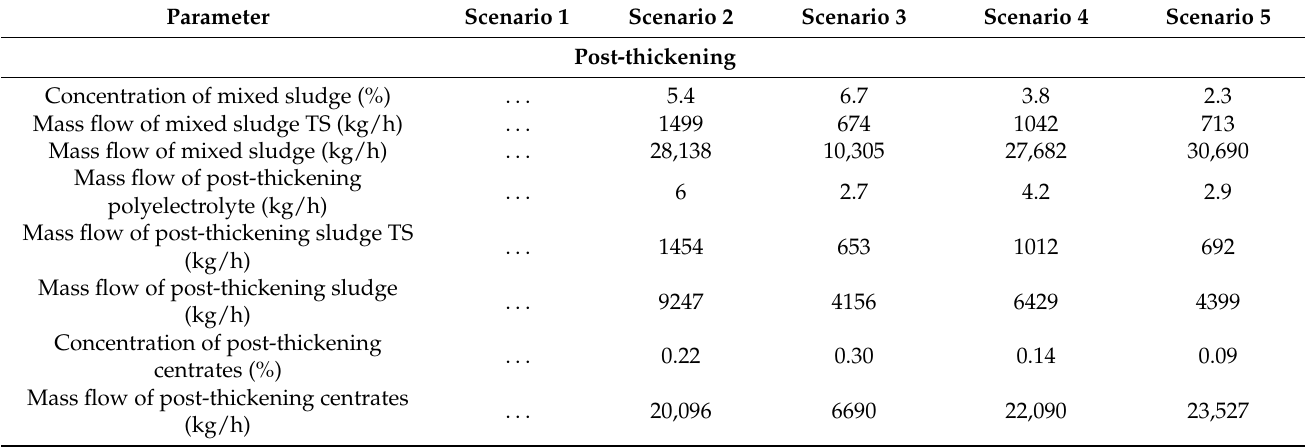
Table 6. Parameters obtained from the sludge line for the economic balance (Case I)